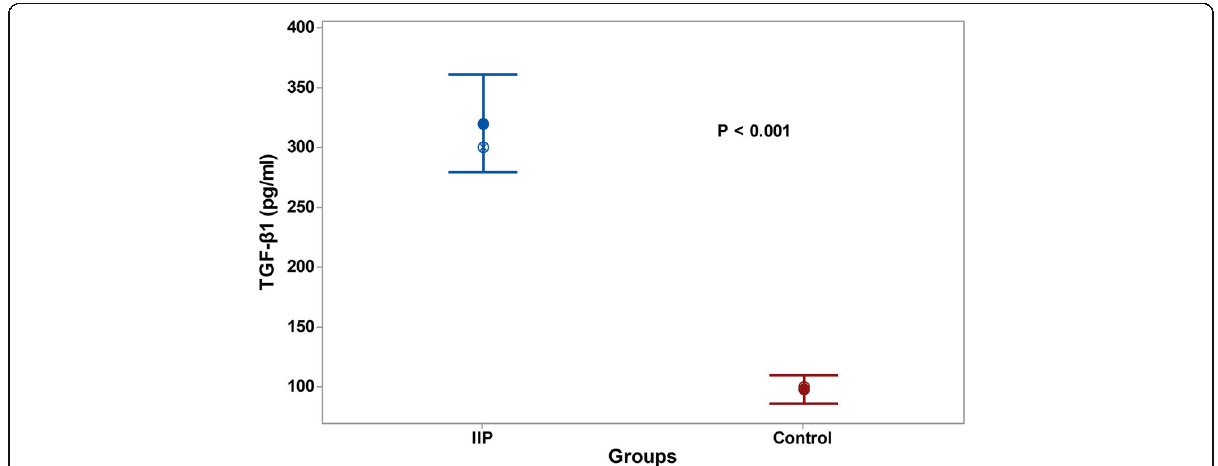
Fig. 2 The serum level of transforming growth factor β 1 in both groups